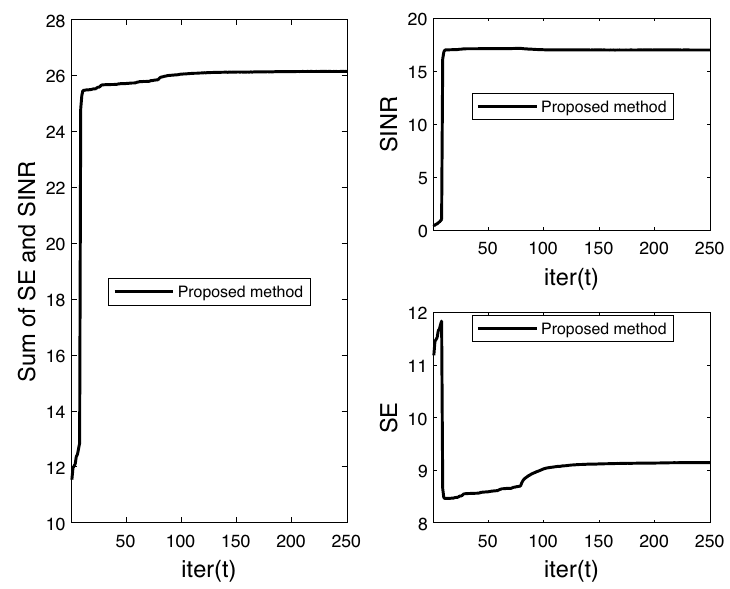
Fig. 1 The convergence behaviors of the consensus-ADMM when N t = 64 , N RF = 16 U = 4 , and η =